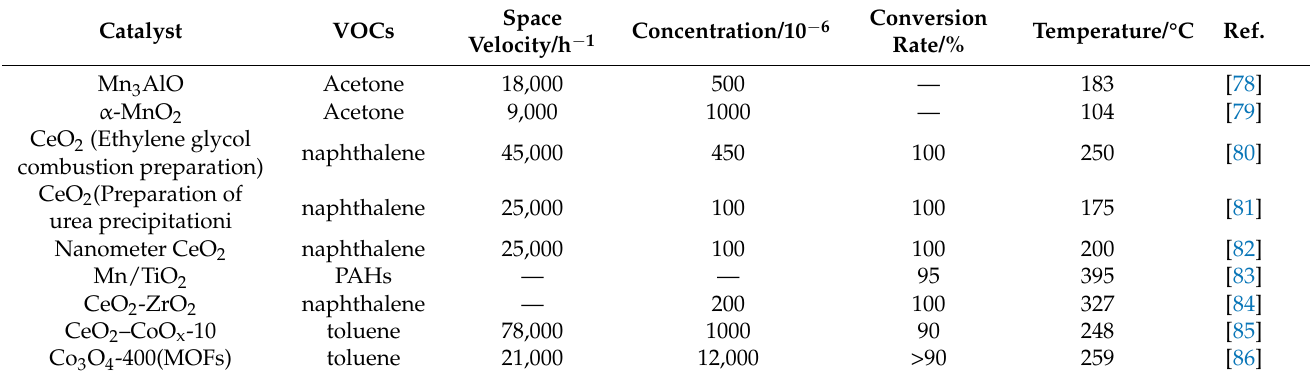
Table 2. Effects of non-noble metal catalysts on the catalytic combustion of VOCs. Adapted with with permission from Ref. [77]. Copyright 2021 Xiaotian